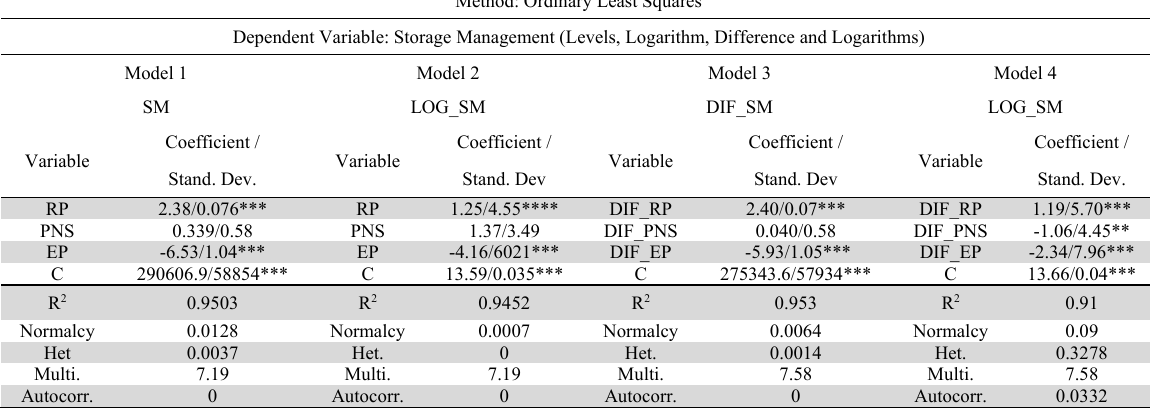
Model Specification for Storage